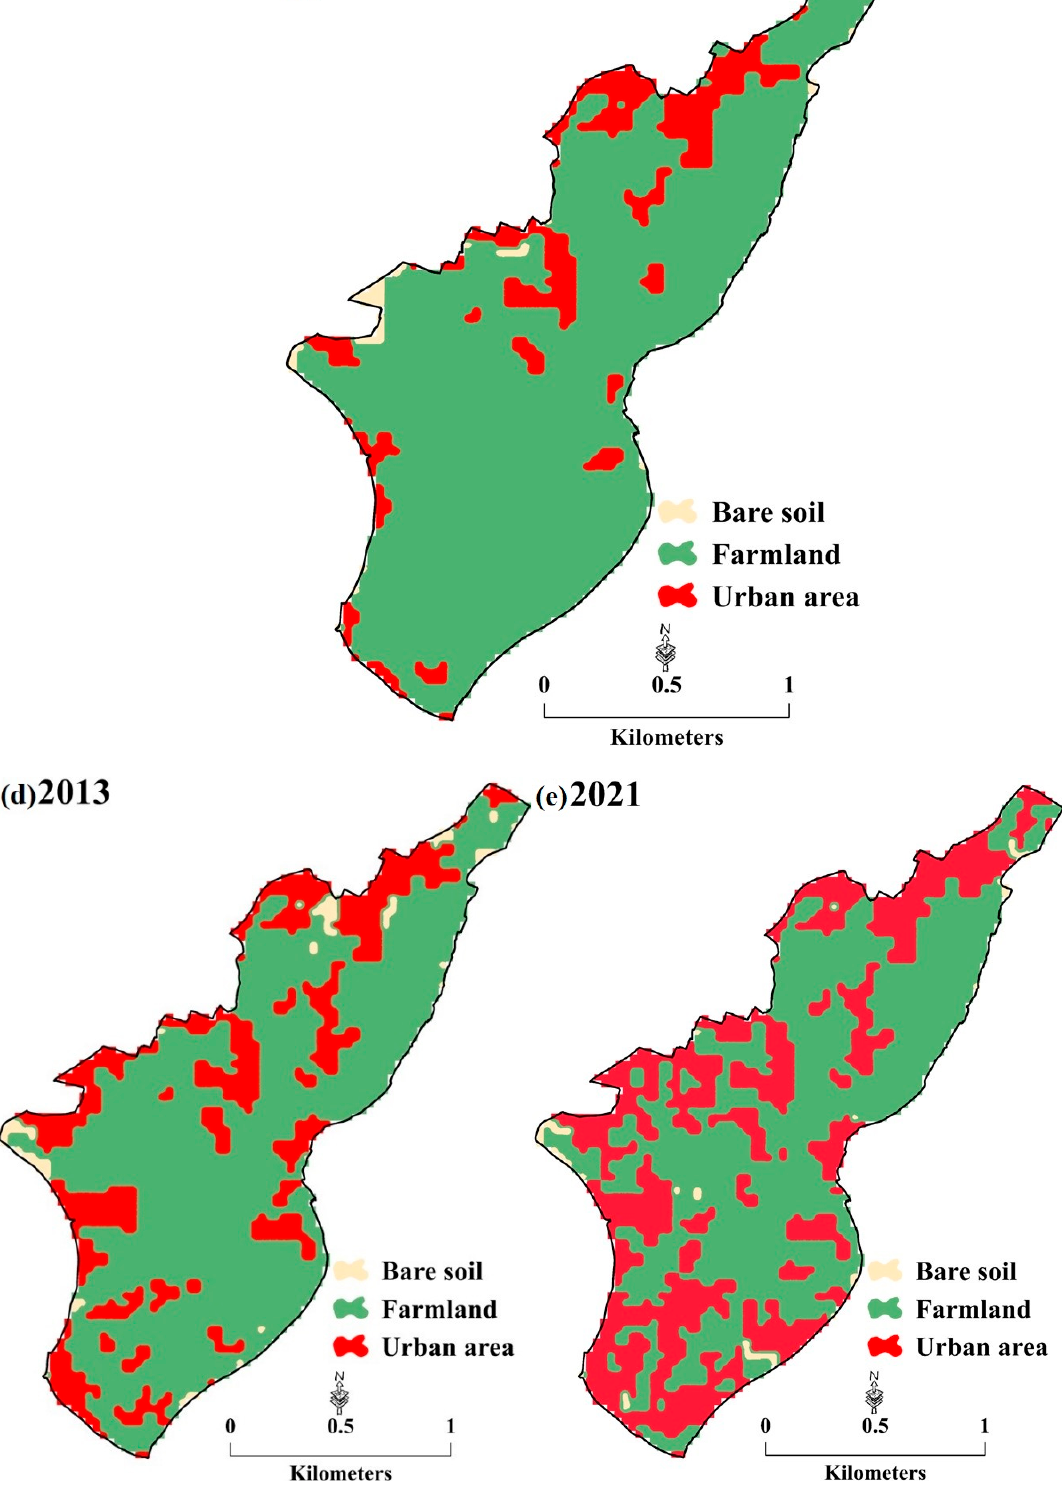
Figure 14. Bare soil (BS), urban area (UA), and farmland LULC classifications in Falaj Daris between 1985–2021.